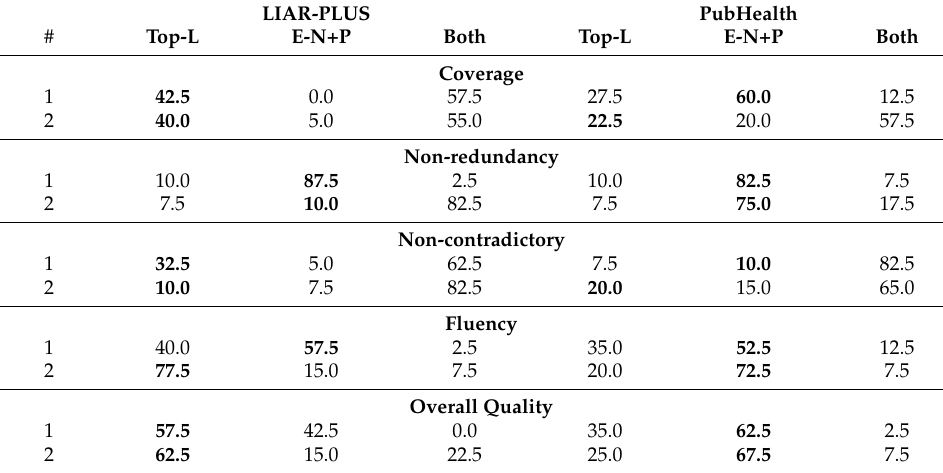
Table 2. Manual annotation results of explanation quality with two annotators for both datasets. Each value indicates the relative proportion of when an annotator preferred a justification for a criterion. The preferred method, out of the input Top-N and the output of our method, Top-N+Edits-N+Para, is emboldened, Both indicates no